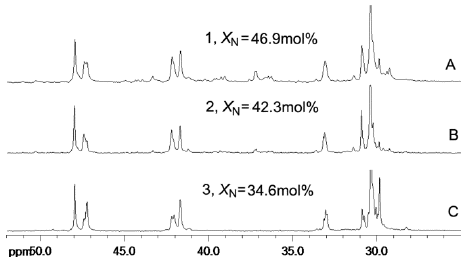
Figure 5. 13 C NMR spectra of the polyethylenes obtained from 1 – 3 /MAO at 4 g norbornene addition (entries 3, 7, and 9 in Table 2).